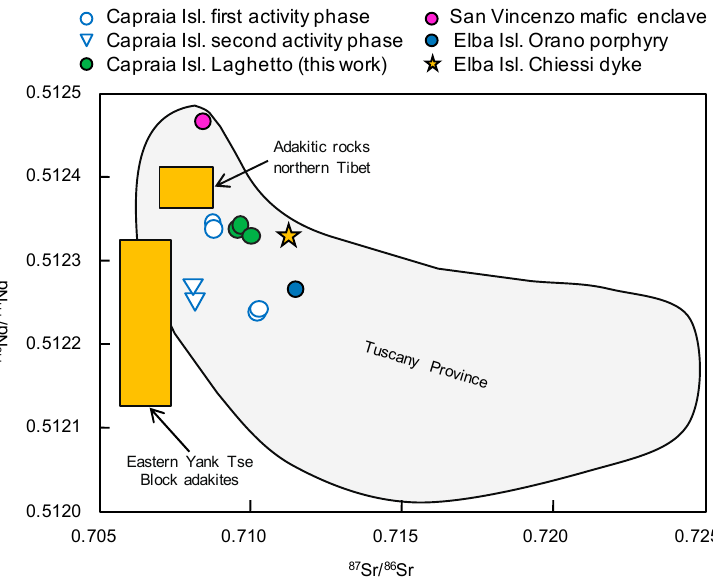
Figure 9. Nd vs. Sr isotope ratios for Laghetto rocks. In grey is shown the Sr and Nd isotope area of the Tuscan province. Data from other adakite localities (orange areas) are reported for comparison [19].